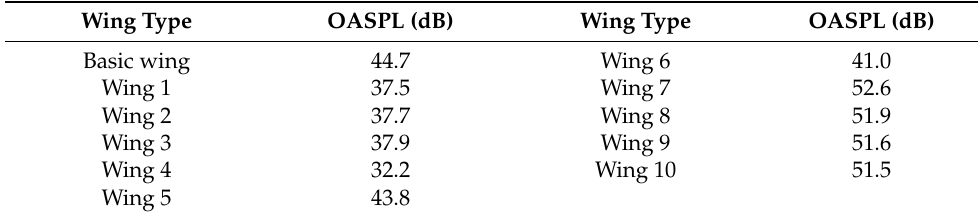
Table 3. Overall sound pressure level of different bionic wings.